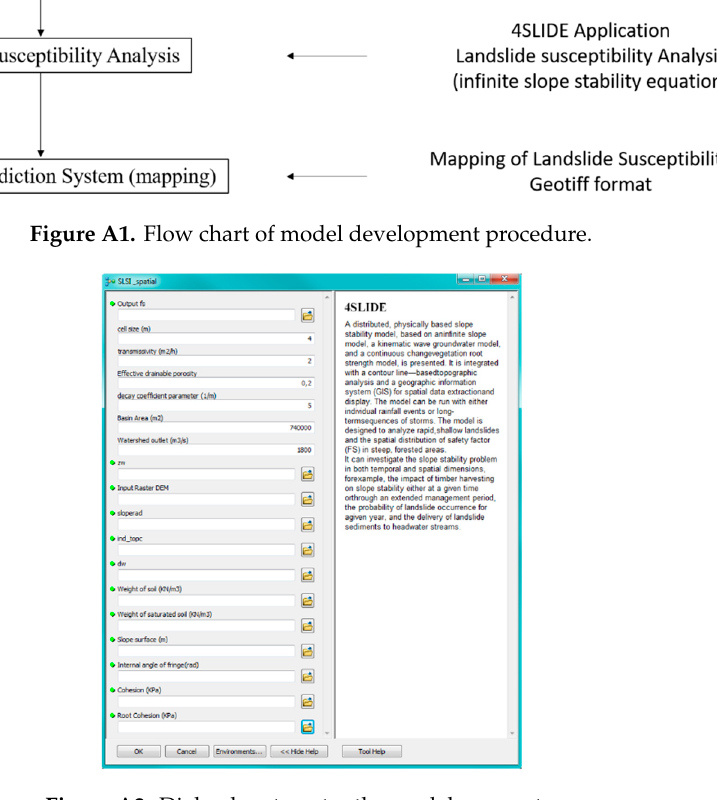
Figure S2. Dialog box to enter the model parameters.